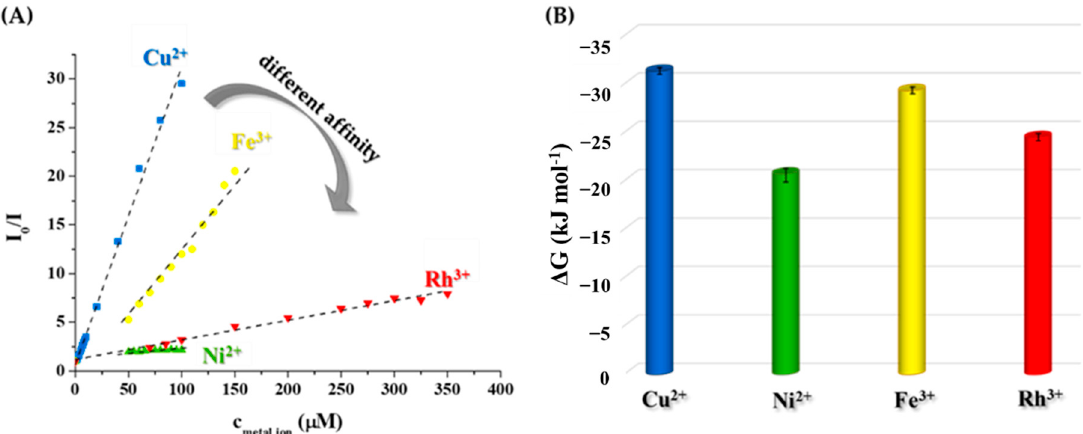
Figure 5. ( A ) Average relative fluorescence intensities of the Tyr-AgNCs after the addition of metal ions in the determined dynamic ranges at 25 °C (c Ag = 18.75 μ M, λ ex = 320 nm, λ em = 410 nm, I = 1 M by NaCl). ( B ) Calculated Δ G values of the interaction between metal ions and NCs at 298 K.